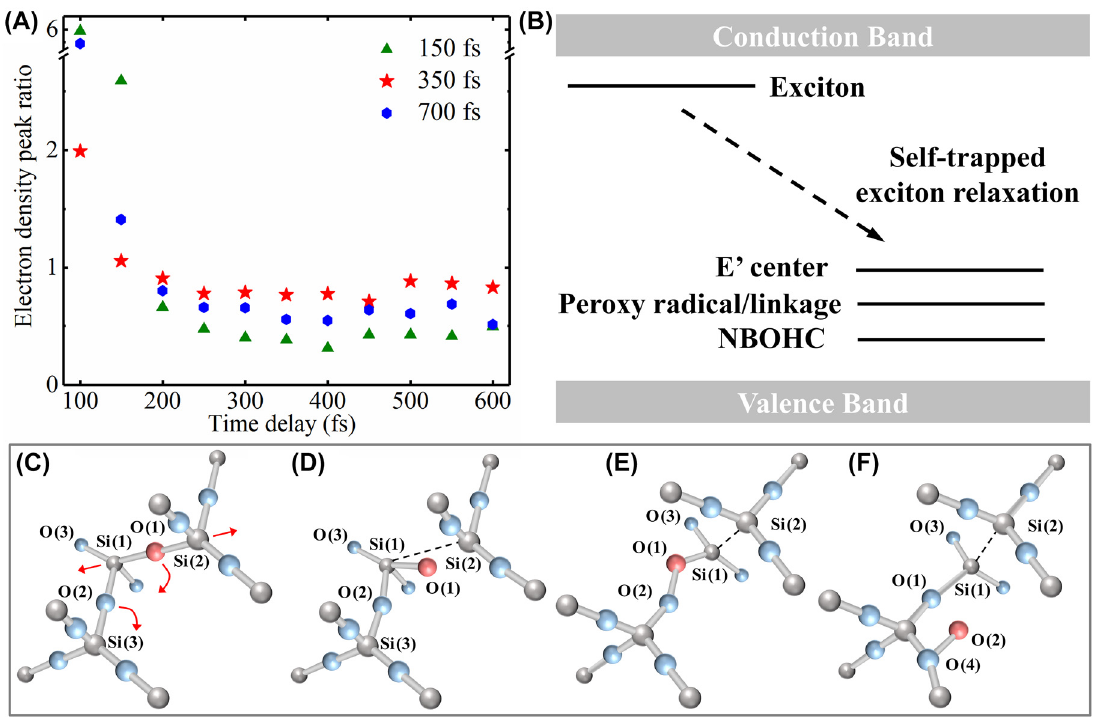
with double-pulse e-max